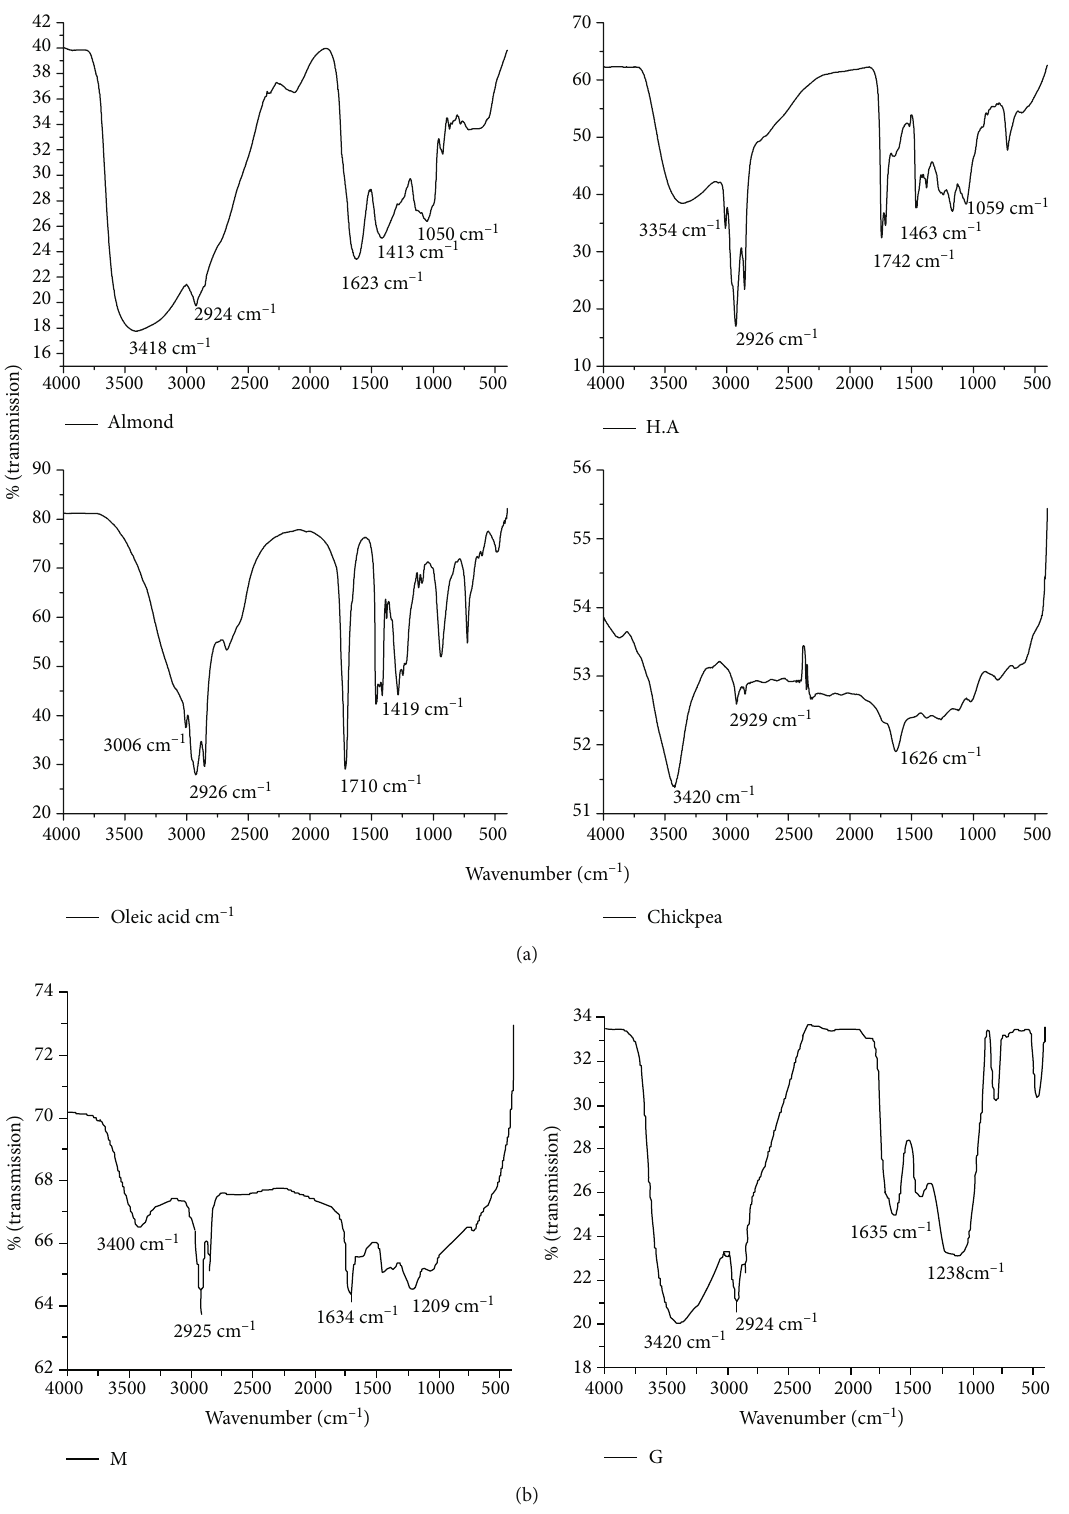
Figure 1: (a) FTIR spectra of almonds, H. antidysenterica (HA), oleic acid and chickpea. (b) FTIR spectra of mixture (M) and granules